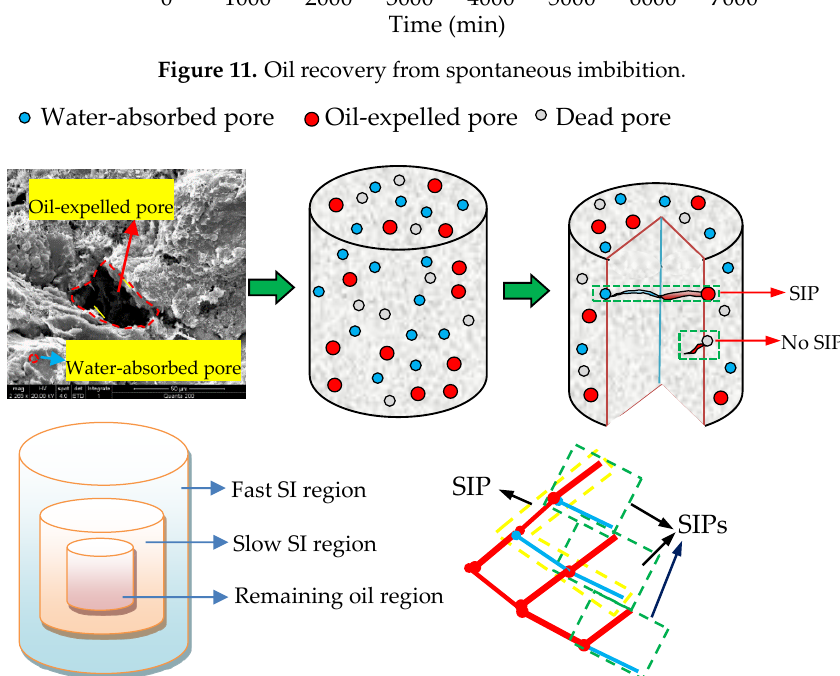
Figure 12. Schematic diagram of SIP control SI mechanism.